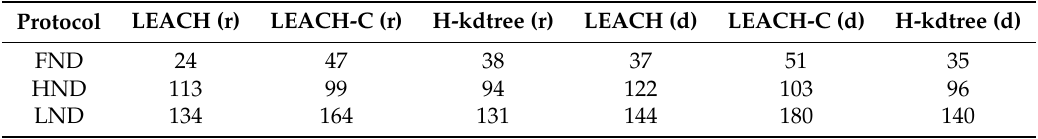
Table 9. Comparison of network lifetime with respect to FND, HND and LND with 200 nodes. (r) random—(d)